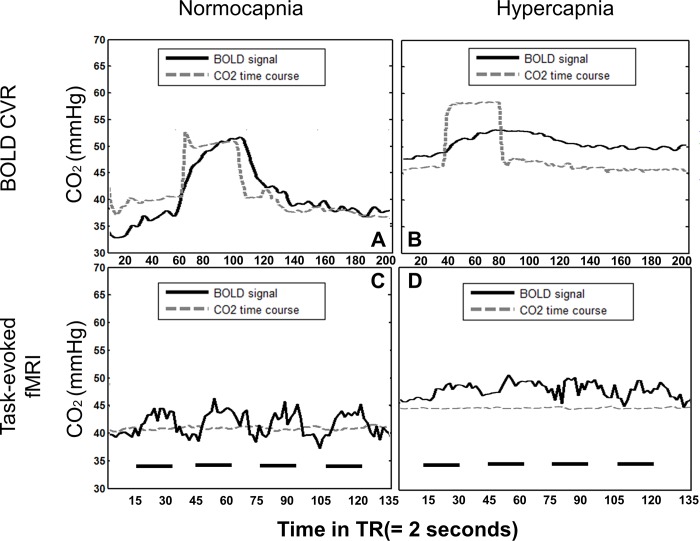
Illustration of the combined BOLD-CVR and task-evoked BOLD-fMRI study protocol in one subject.Top: Fig 1A and 1B show the CO2 (grey dotted line) and mean BOLD signal time course (black line) during a BOLD-CVR study at CO2 baseline (A) versus hypercapnia (B), respectively. Note that the BOLD signal follows the CO2 increase from normocapnia and quickly returns to baseline levels. However, during hypercapnia, the mean BOLD signal increase with CO2 rise is less than in normocapnia. Bottom: Fig 1C and 1D show the CO2 time course during a task-evoked BOLD-fMRI block protocol. The black short lines represent the task phase of the protocol. The ability of precise CO2 control with the MPET method produced a constant CO2 level at CO2 baseline (C) versus hypercapnia (D), respectively.